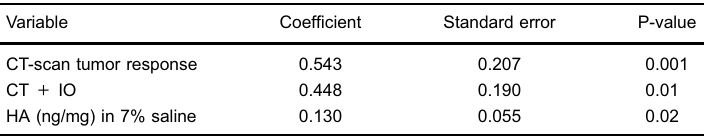
Table 3 . Cox proportional hazard model of survival time in a cohort of 51 patients with metastatic